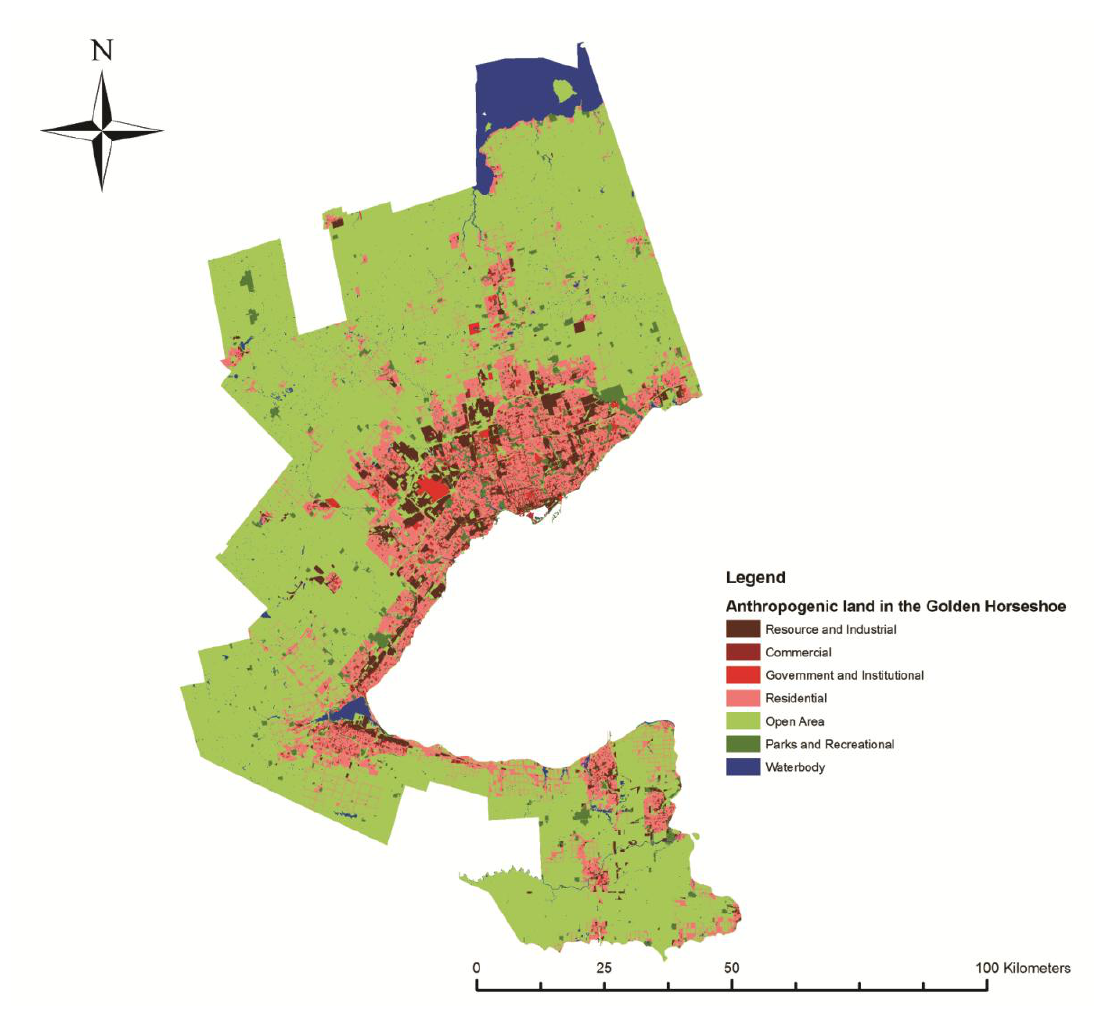
Figure 1. Typologies of anthropogenic land use in the Golden